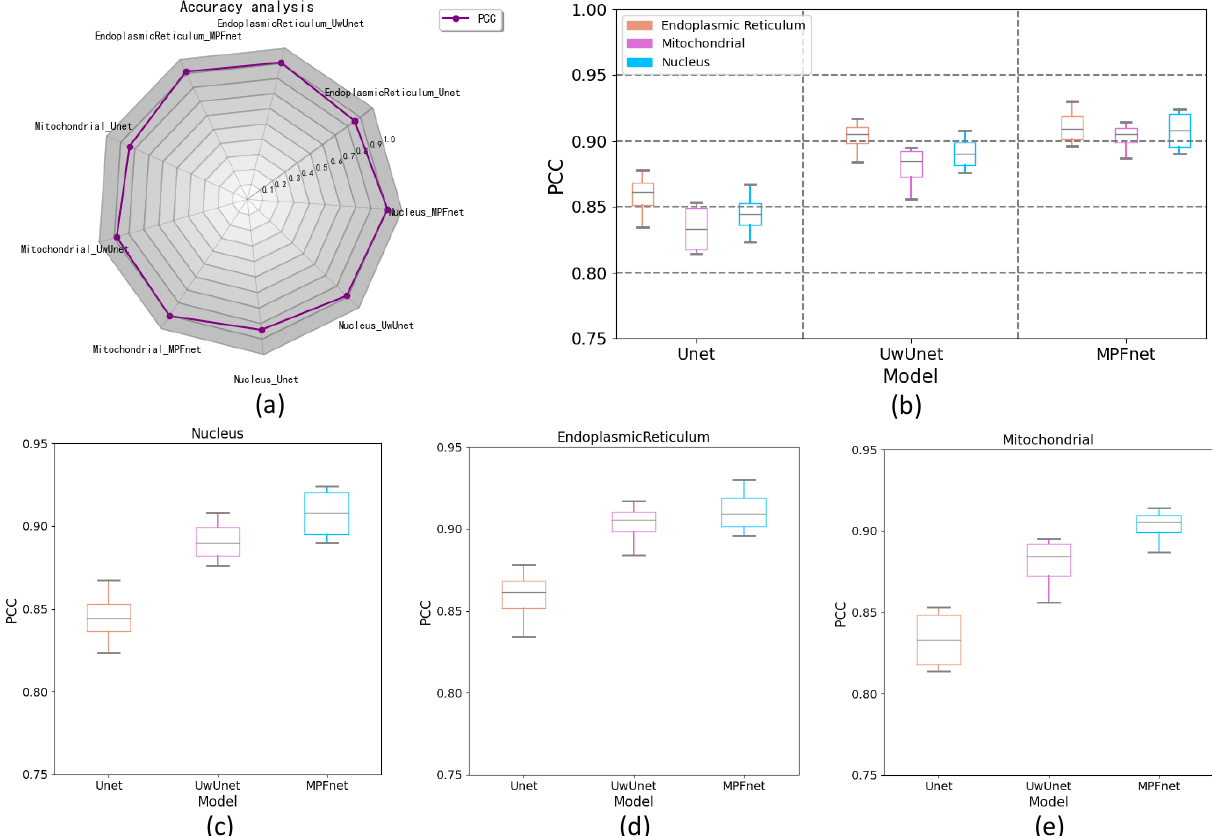
Figure 7. Comparing PCC performance among various prediction algorithms. ( a ) PCC radar chart for quantitative comparisons of different predictive models. ( b ) Box plot of PCC value over all organelle (nuclei, mitochondria, and endoplasmic reticulum) prediction task sets with MPFnet-based learning model and compared with that of varied deep neural network-based prediction models, such as Unet and UwUnet learning model. ( c ) Box plot of PCC value on nuclei prediction task set with MPFnet-based learning model and compared with that of varied deep neural network-based prediction models such as Unet and UwUnet learning model. ( d ) Box plot of PCC values on endoplasmic reticulum prediction task set with MPFnet-based learning model and compared with that of varied deep neural network-based prediction models such as Unet and UwUnet learning models. ( e ) Box plot of PCC values on mitochondria prediction task set with MPFnet-based learning model and compared with that of varied deep neural network-based prediction models such as Unet and UwUnet learning model.